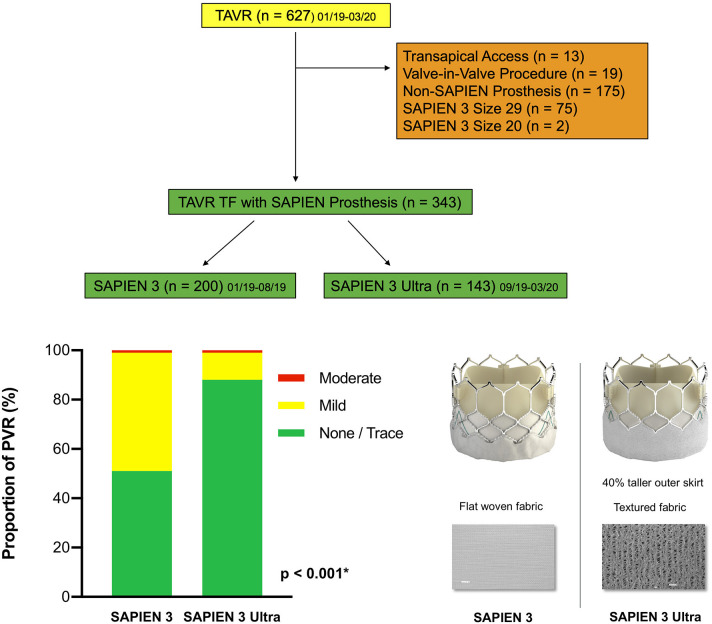
Patient population. A total of 627 patients undergoing TAVR from January 2019 until March 2020 at the Heart Valve Center Mainz were screened. Reasons for exclusion are displayed on the right side. Finally, 200 patients with a SAPIEN 3 and 143 patients with a SAPIEN 3 Ultra were enrolled in the study. TAVR, transcatheter aortic valve replacement; TF, transfemoral access. Central illustration. Impact on paravalvular regurgitation: The SAPIEN 3 Ultra significantly lowers the rate of paravalvular regurgitation after TAVR compared to the SAPIEN 3. The SAPIEN 3 (left) and last-generation SAPIEN 3 Ultra prostheses (right). The novel SAPIEN 3 Ultra features a taller, textured polyethylene terephthalate outer skirt with ~40% increase in height. All other prosthesis components remained unchanged from the SAPIEN 3. PVR, paravalvular regurgitation. P-value was calculated by Chi squared test. Data represented as percentage of total.